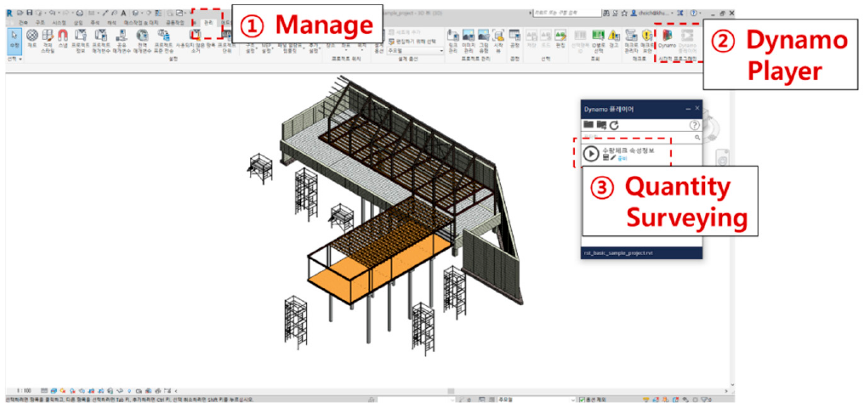
Figure 8. Automatic extraction of the attribute information for the temporary facilities quantity inspection using Dynamo.